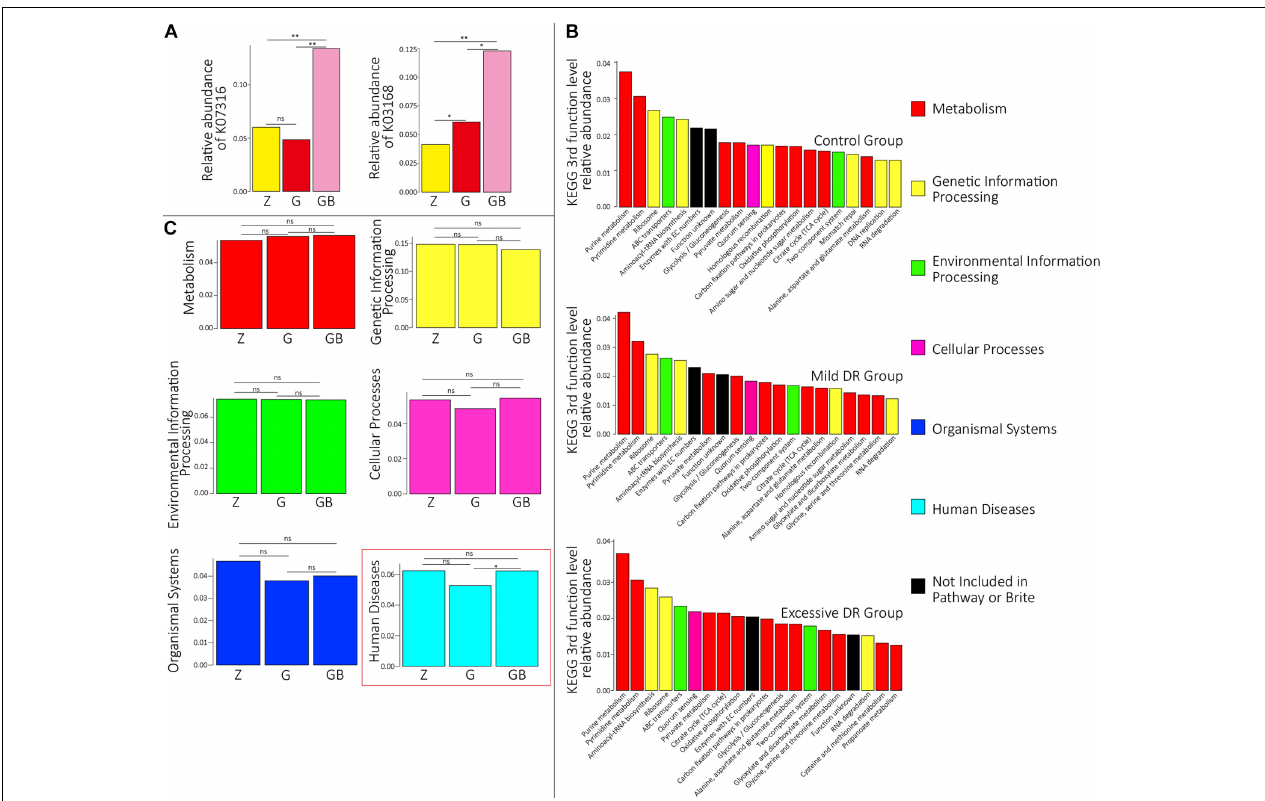
FIGURE 2 | Protein functional annotation analysis. (A) KOs with a significant difference in the relative abundance between groups. Z for the control group, G for the mild DR group, GB for the excessive DR group. ns: non-significant, *0 . 01 < p < 0 . 05, ** p < 0.01. (B) The top 20 KEGG third-level pathways with the highest average relative abundance of each group, different colors in the legend indicate different KEGG first-function-level pathways. (C) The difference of relative abundance of each of six KEGG first-function-level pathways among groups. Z for the control group, G for the mild DR group, GB for the excessive DR group. ns: non-significant, p > 0.05; *0 . 01 < p < 0 .